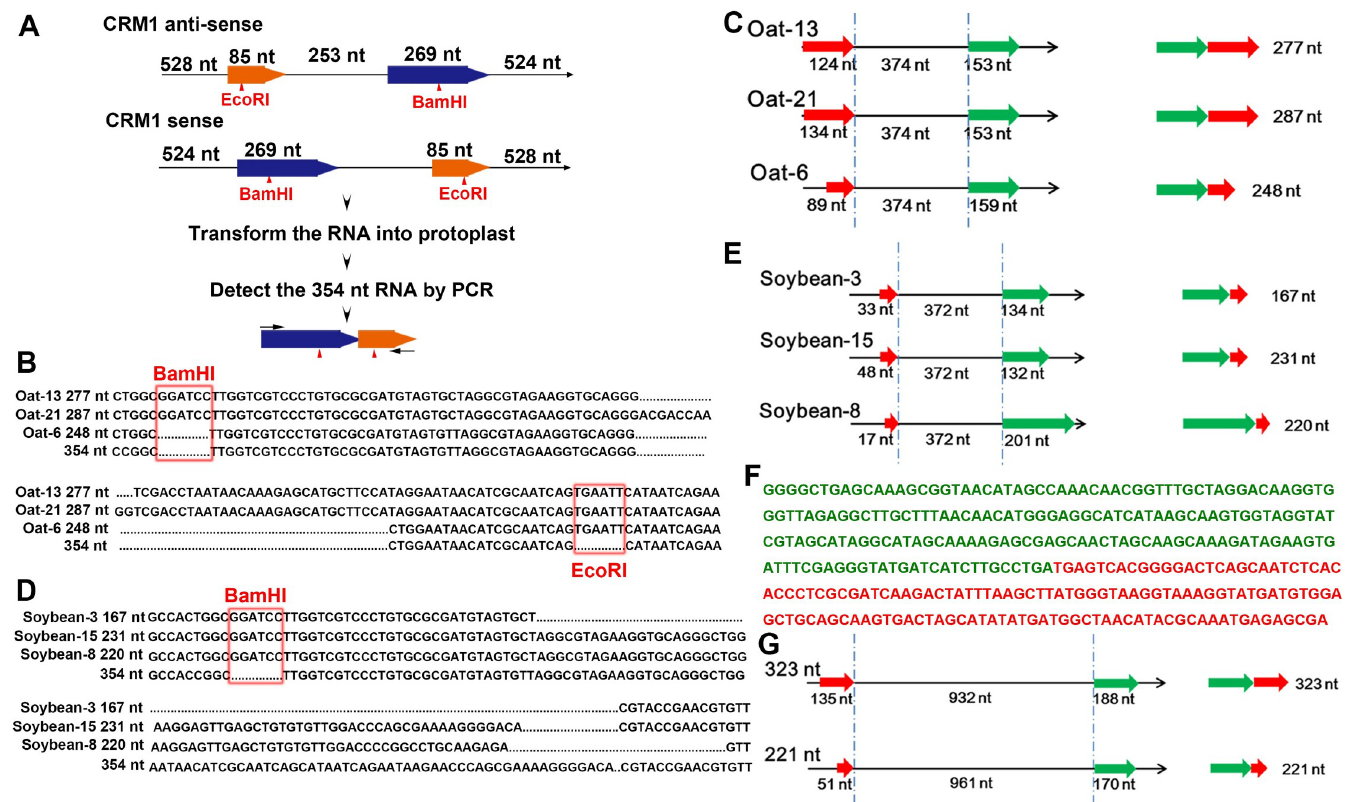
Fig 5. Conserved back-splicing process of retrotransposons in numerous crops. (A) The procedure of protoplast transformation using in vitro–transcribed CRM1 RNA. The digestion sites are marked with red triangles. (B and D) Three 354-nt–like back-spliced RNAs from transformed oat (B) and soybean (D) protoplasts. The red frames mark the labeled digestion sites. The first 3 tracks show the sequences from transformed protoplasts, and the last tracks show the 354-nt RNA sequence. (C and E) The detailed information of the 3 back-spliced sequences from oat (C) and soybean (E) protoplasts. The left panels show the sequence position on the 1,671-nt sequence. The right panel shows the final back-spliced sequences. The dotted lines mark the intermediate region. The green bars show the downstream parts of the 1,671-nt sequence, and the red bars indicate the upstream parts. (F) A 323-nt back-spliced RNA from wheat retrotransposons, consisting of a 288-nt (green) and a 135-nt (red) sequence. (G) Detailed information for the 323-nt and 221-nt back-spliced sequences. The left panel shows the position of the sequence on the retrotransposon, while the right panel shows the final back-spliced sequences. The dotted lines indicate the intermediate region, green bars represent the downstream regions, and red bars indicate the upstream regions. CRM, centromeric retrotransposon; nt,